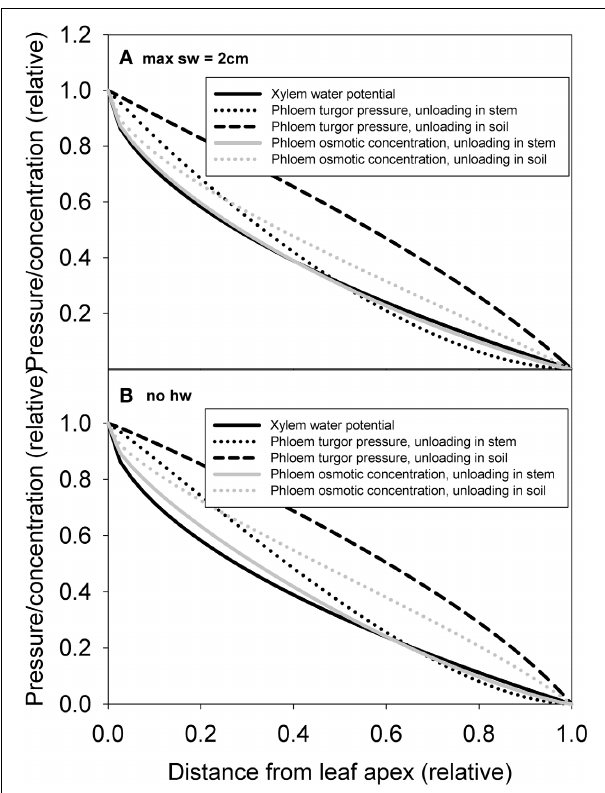
FIGURE 9 | Simulated turgor pressure difference between leaf and root phloem as a function of tree height with varying parameterization for a case where all phloem unloading occurs in the root (A) and evenly along the stem (B) for pine. “sw = 2cm” refers to a scenario where maximum sapwood depth was assumed to be 2cm, and “no hw” refers to a scenario of no heartwood formation, i.e., all of the xylem was assumed to be conducting. “ K p , tot ∗ 2,” and “ K p , tot ∗ 0.5” refer cases where the absolute phloem conductance has been multiplied by a factor of 2 and 0.5,